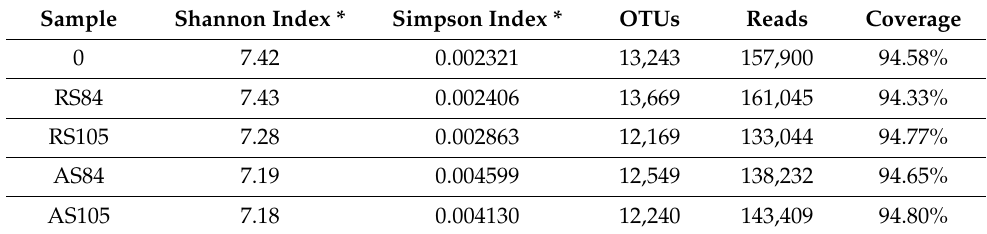
Table 3. Biodiversity indexes, operational taxonomic unit (OTU) numbers, and total reads after